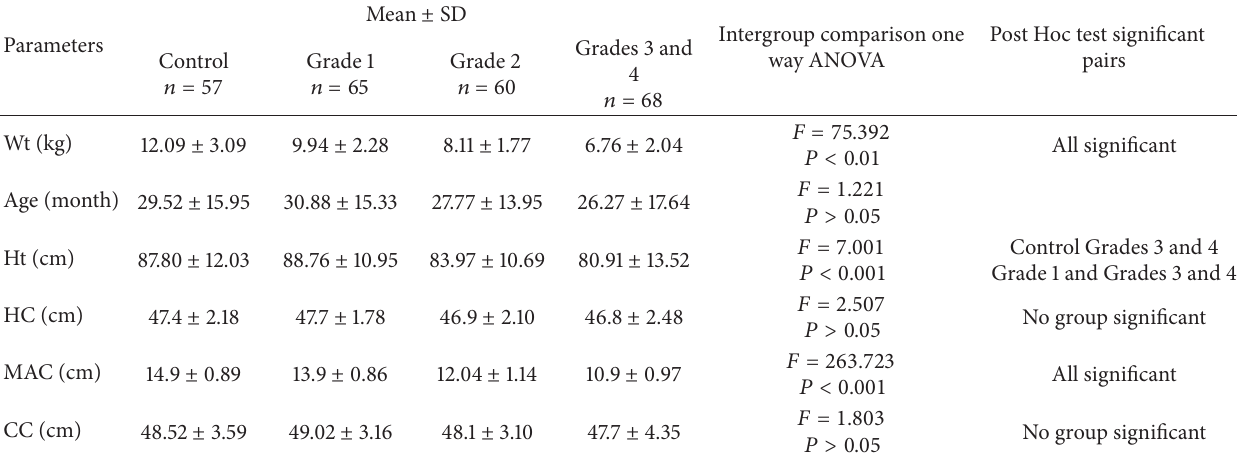
Table 1: Anthropometric measurements in cases of malnutrition and